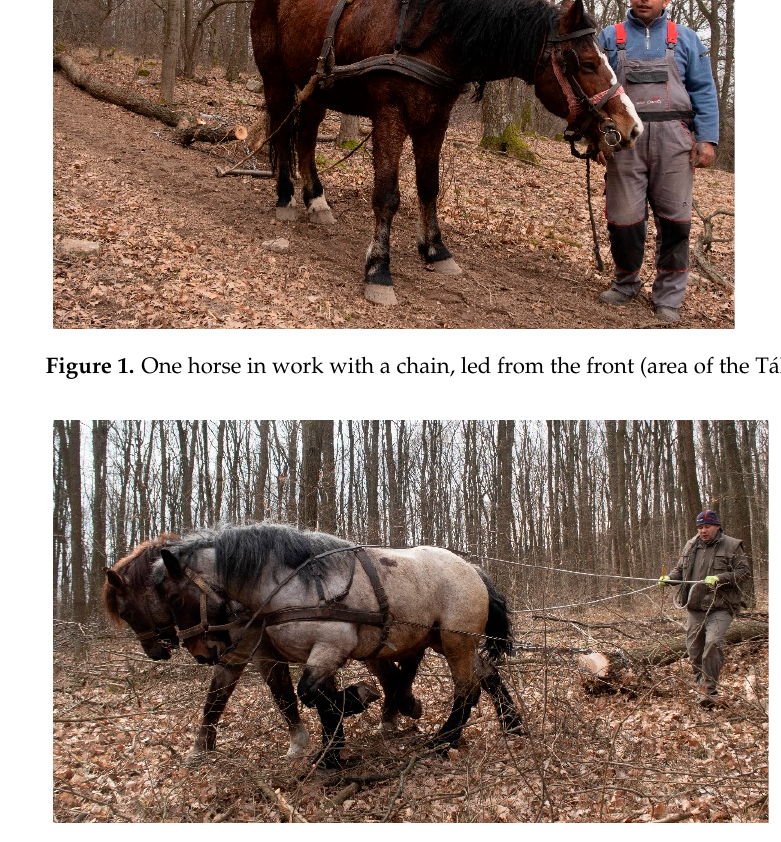
Figure 2. Horses working in pair with a chain, led from the back (area of the Királyrét Forest District, 2021).